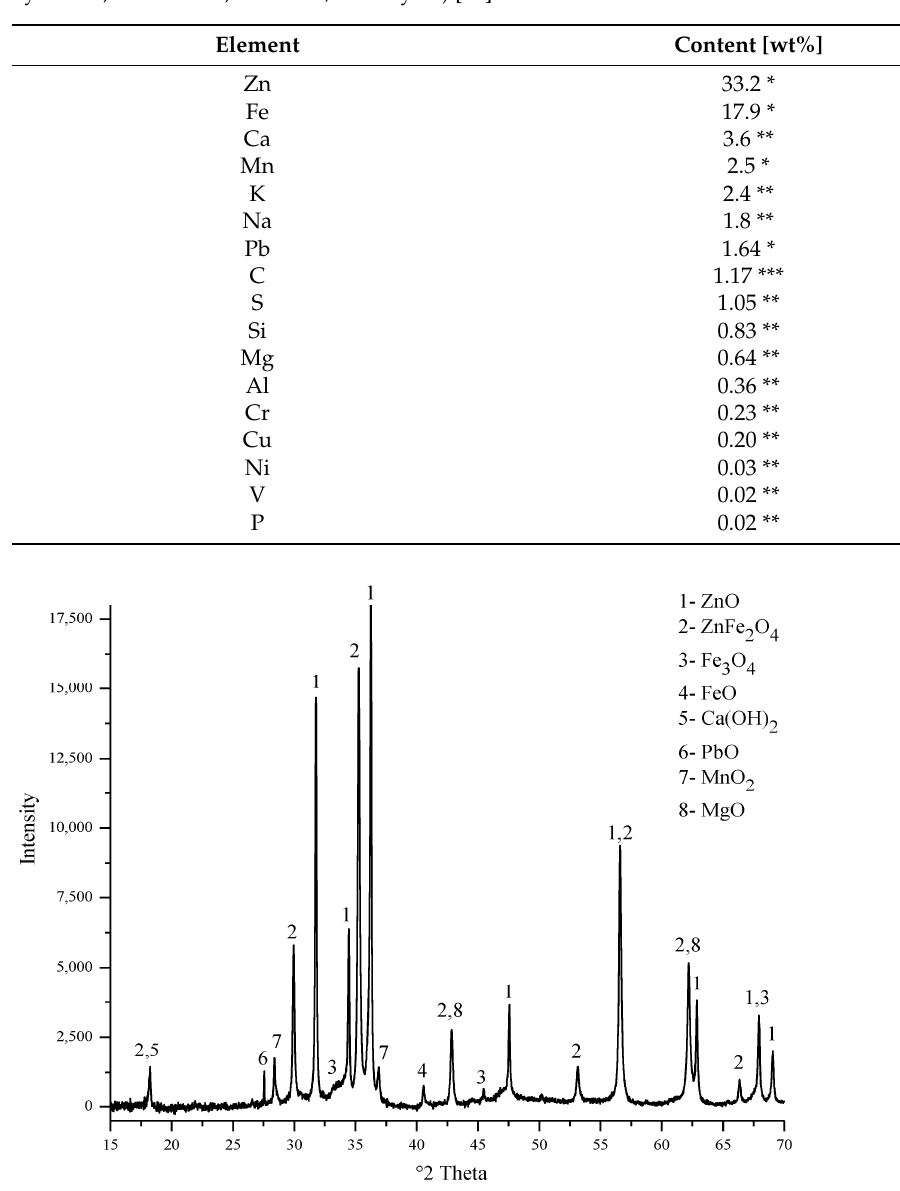
Table 1. Chemical analysis of the main elements in the EAFD sample (total acid digestion, measured by * AAS, ** ICP-OES, and *** S/C analyser) [14].